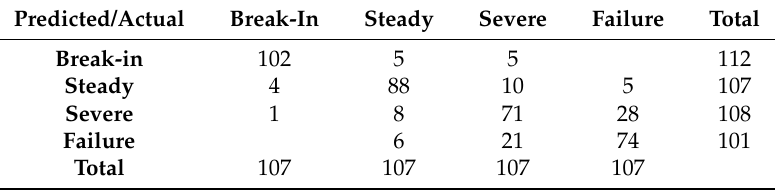
Table 2. The confusion matrix with the results obtained with the test set. Break-In